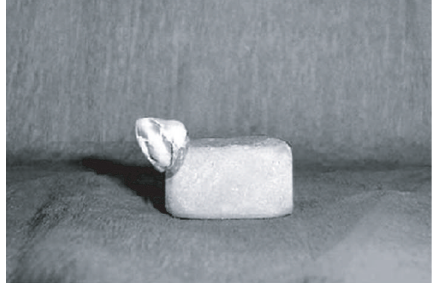
Figure 4: After glazing group B top view.